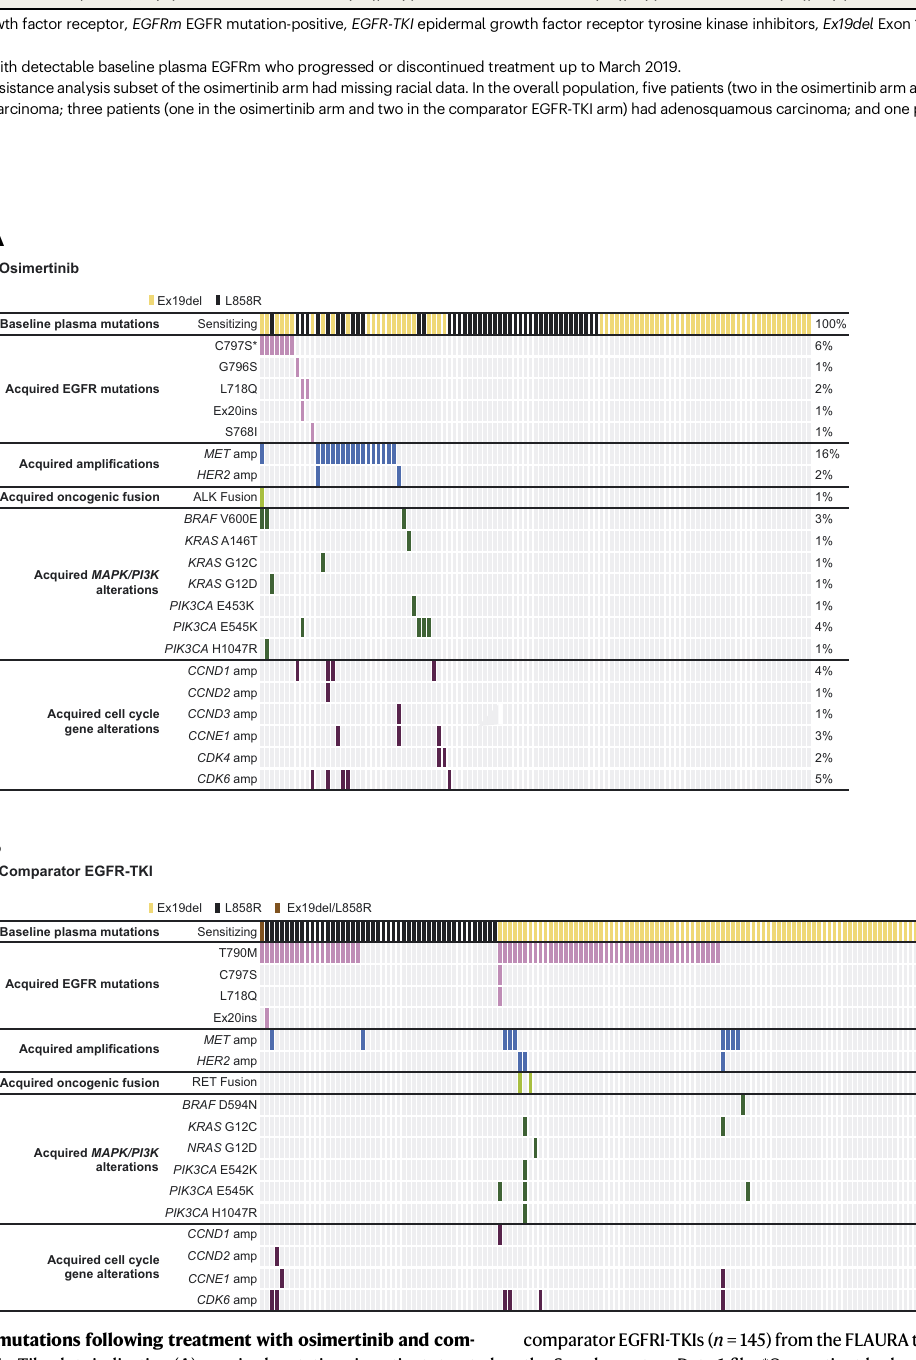
Characteristic Osimertinib